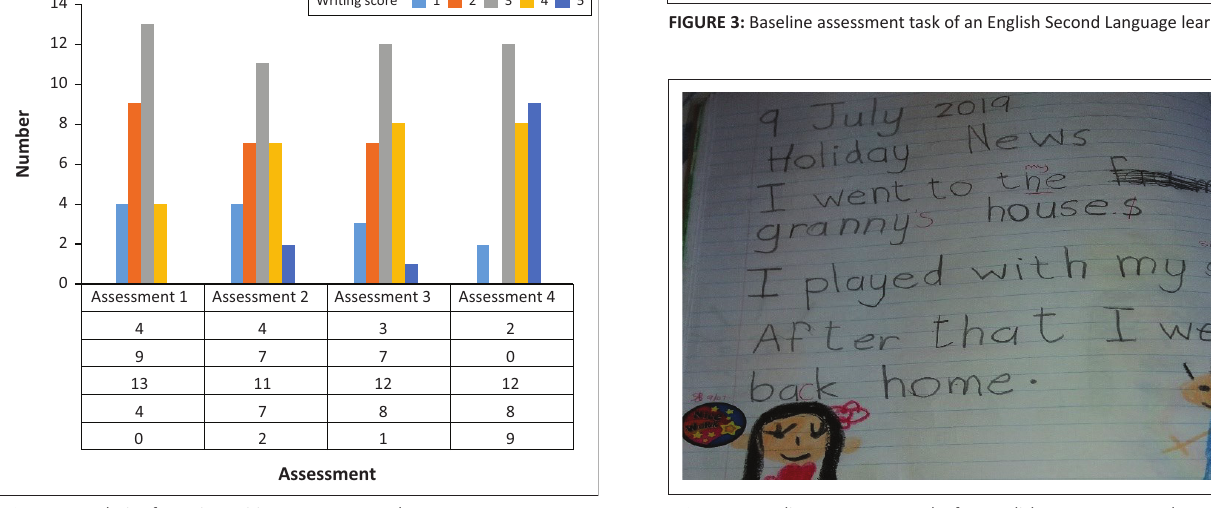
FIGURE 4: Baseline assessment task of an English Home Language